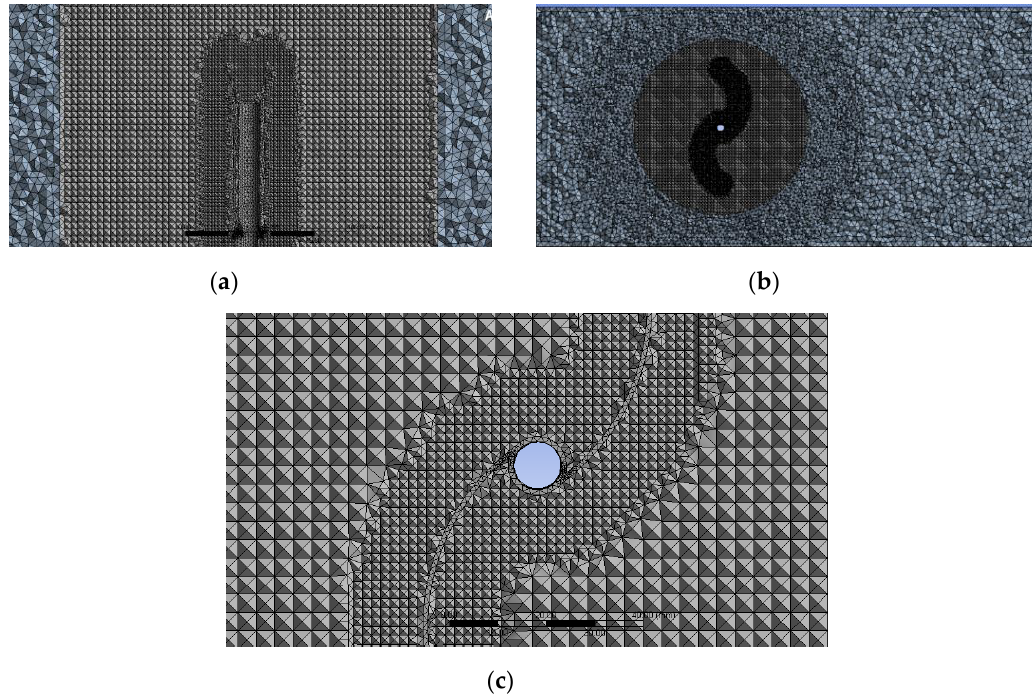
Figure 13. Mesh of the IceWind turbine domain (zoomed in): ( a ) elevation, ( b ) plan, and ( c ) plan (zoomed in).